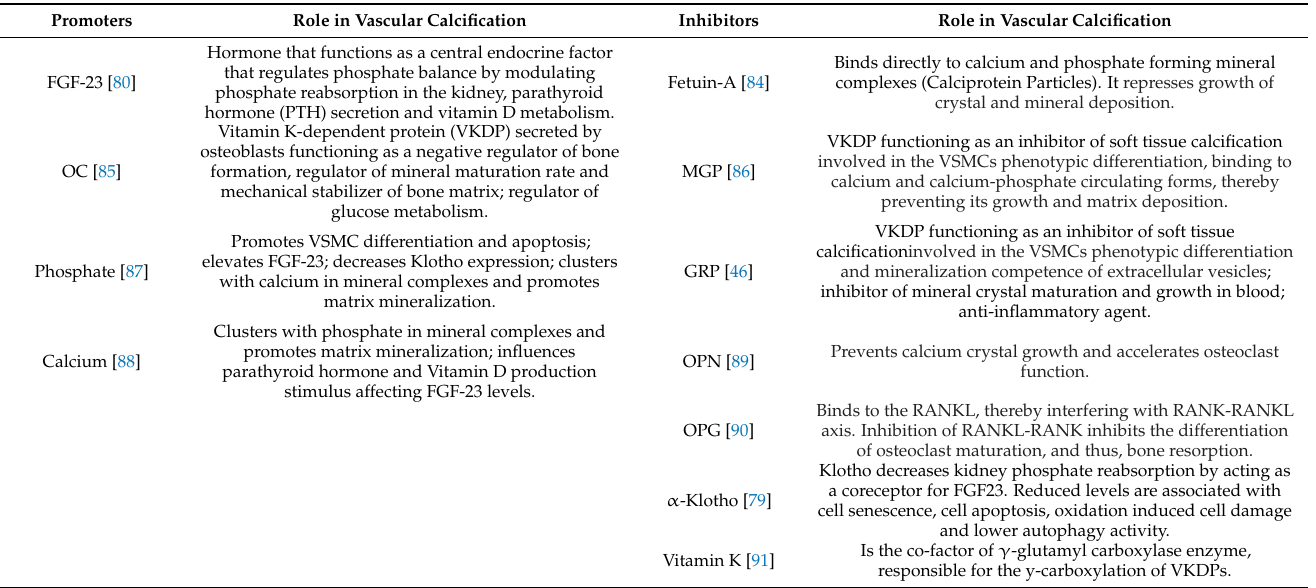
Table 2. Vascular Calcification Players Associated with Mineral